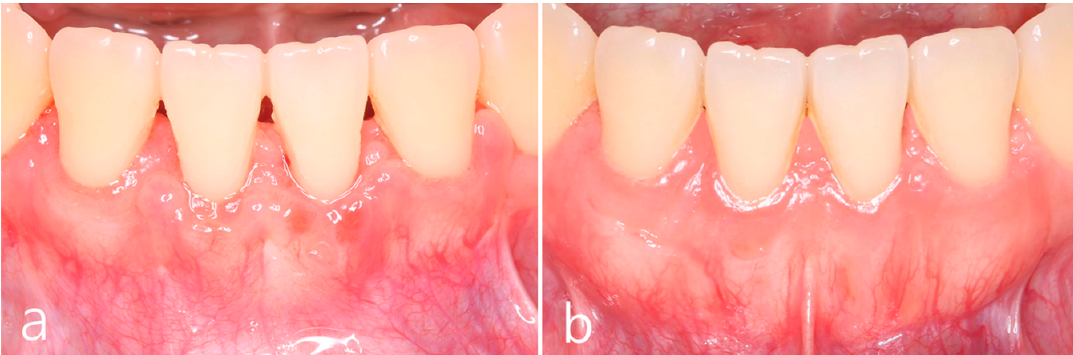
Figure 3. ( a ) Clinical fi ndings at 6 months after surgery showed reduced gingival recession in the left lower central incisor and improved soft tissue phenotype. ( b ) The 5-year postoperative clinical fi nding showed improved soft tissue phenotype. Interdental concavity was also improved. The cross-sectional CBCT scans 5 years after the surgery showed well maintained labial bone plate at the midfacial side of the lower right and left central incisors (Figure 4a,b). On the cross-sectional CBCT scan at the interdental site between the lower left cen- tral and lateral incisors, partial depression was present, although the hard tissue pheno- type improved overall (Figure 4c). On a cross-sectional CBCT scan, hard tissue phenotype modi fi cation was observed on the labial side at the interdental site between the lower right central and lateral incisors (Figure 4d).